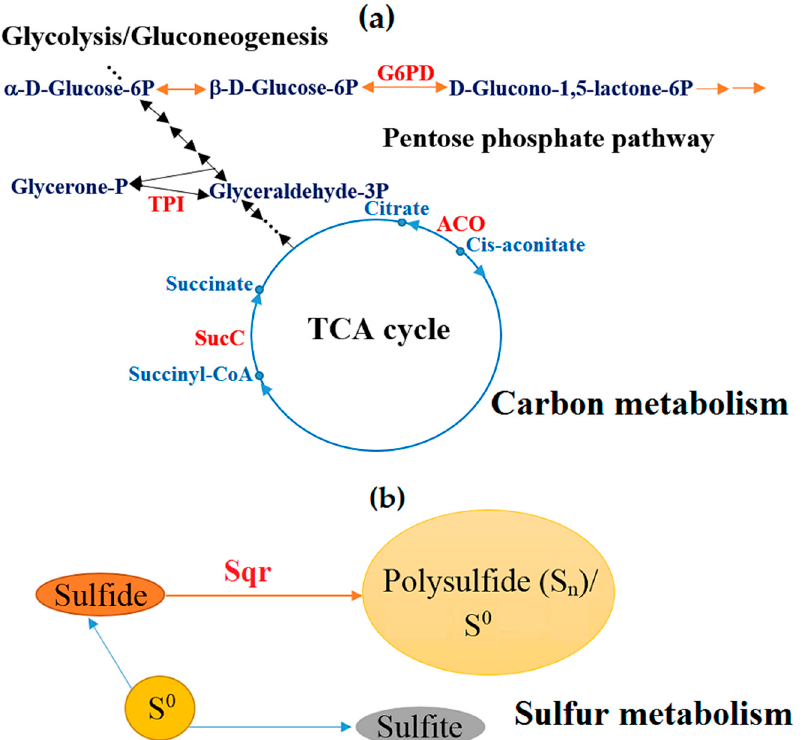
Figure 3. Reinforcement of ( a ) carbon and ( b ) sulfur metabolism pathways in Sb. thermotolerans in response to the gold-bearing pyrite-arsenopyrite concentrate. TPI: Triosephosphate isomerase [EC 5.3.1.1]; G6PD: Glucose-6-phosphate 1-dehydrogenase [EC 1.1.1.49 1.1.1.363]; ACO: Aconitate hydratase [EC 4.2.1.3]; SucC: Succinyl-CoA synthetase beta subunit [EC 6.2.1.5]; Sqr: